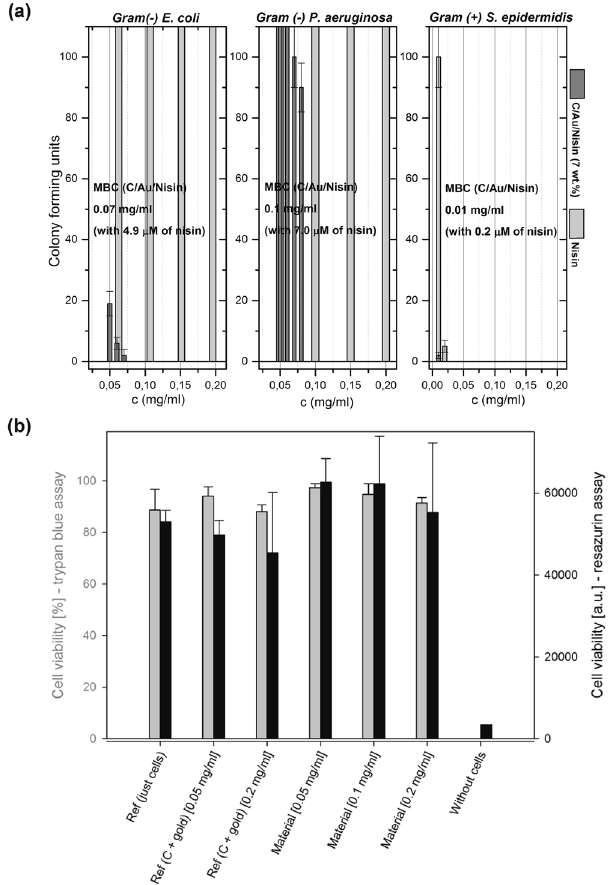
Figure 7. Minimal bactericidal concentrations (MBC) and viability of mammalian cells. MBC concentrations determined for E. coli and P. aeruginosa as Gram negative strains and S. epidermidis as Gram positive strain ( a ); viability of L929 fibroblasts exposed to different concentrations of C/Au/nisin (containing 7 wt.% of pure nisin) determined by Trypan blue (grey) and Resazurin assay (black). The error bars present the standard deviation of three